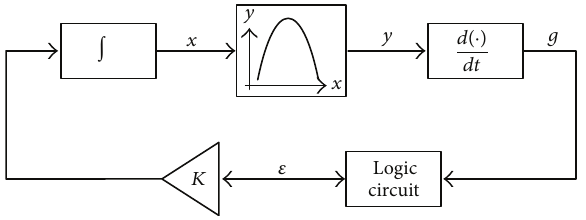
Figure 1: Block diagram of general ESC scheme.